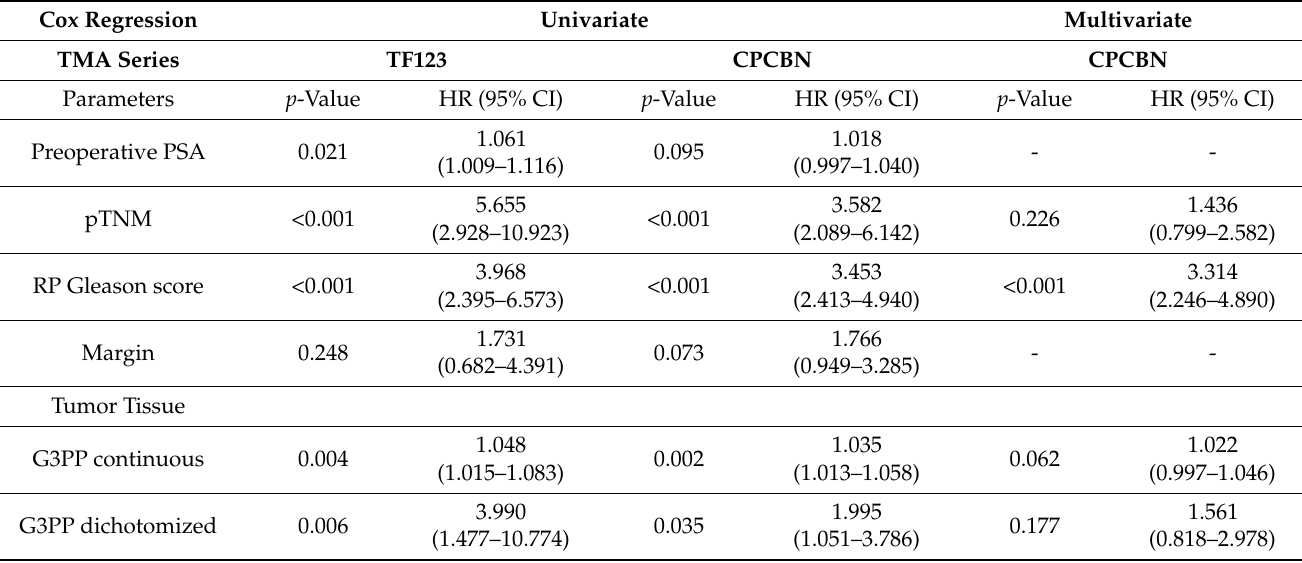
Table 4. Univariate and multivariate Cox regression analyses predicting prostate cancer-specific mortality in the TF123 and CPCBN TMA cohorts after overall